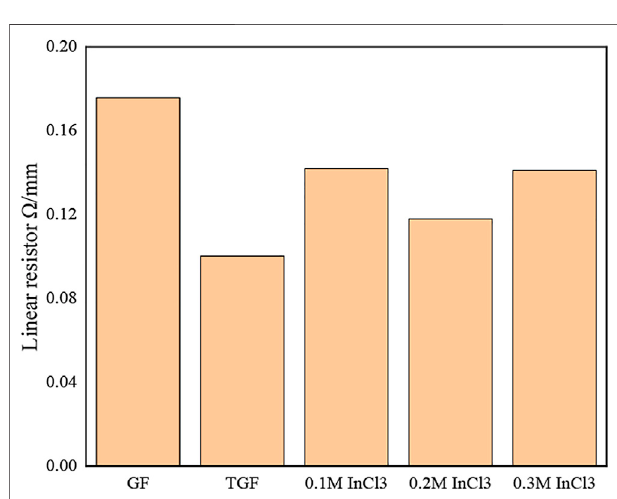
FIGURE 5 | respectively GF; TGF; 0.1 M InCl 3 solution impregnated heat-treated graphite felt; 0.2 M InCl 3 solution impregnated heat-treated graphite felt; 0.3 M InCl 3 solution impregnated heat-treated graphite felt line